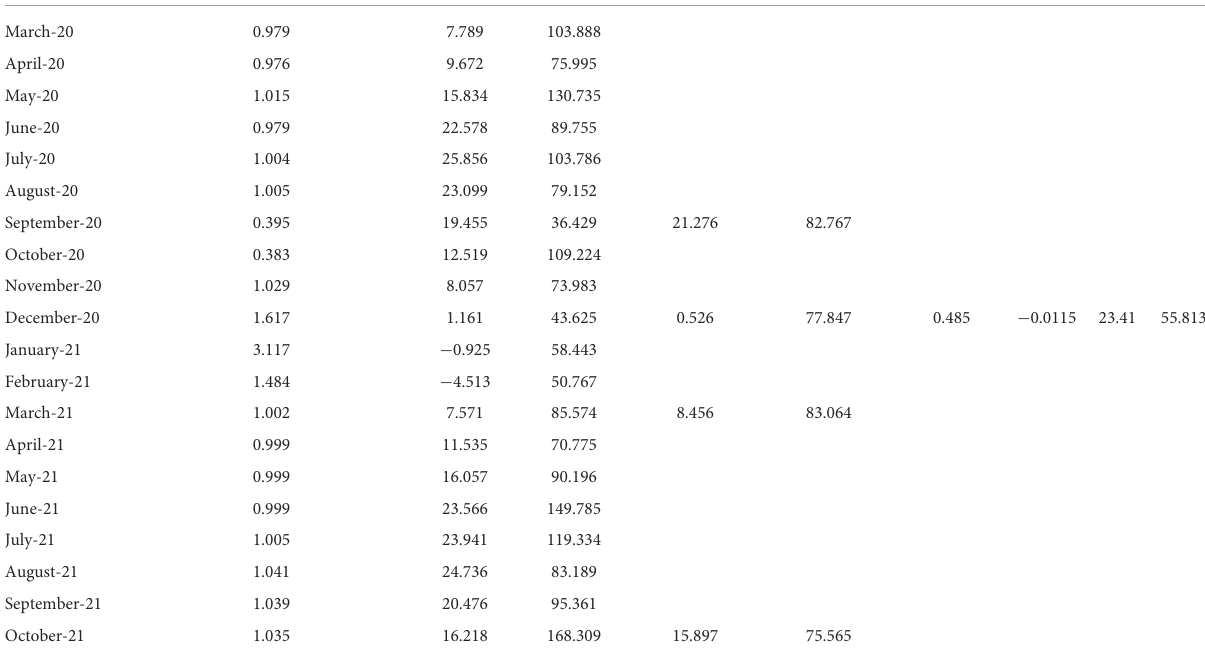
TABLE 1 Mean values by Indiana census tract for variables used in the DBN.